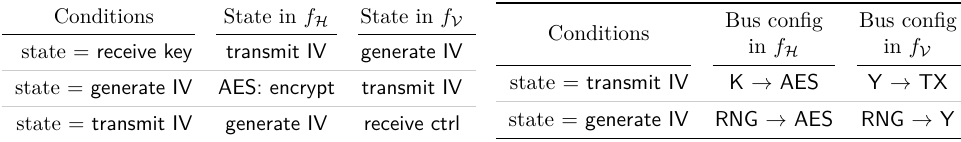
Table 5: Introduced changes in the visible functionality to the FSM state transitions (left) and bus address decoding (right) to enable Evil Twin. Note that this time V resembles the original